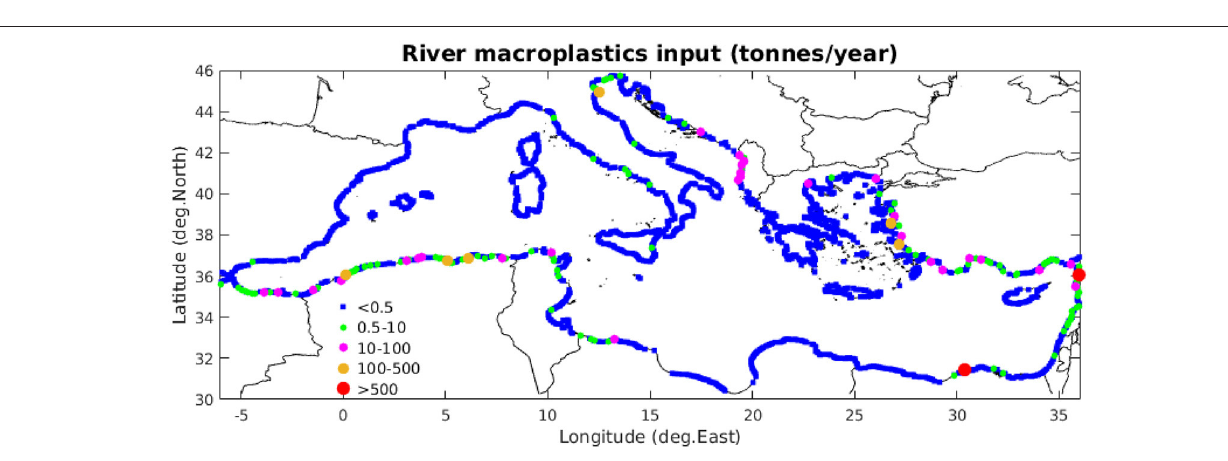
FIGURE 3 | River sources of macroplastic inflow to the Mediterranean